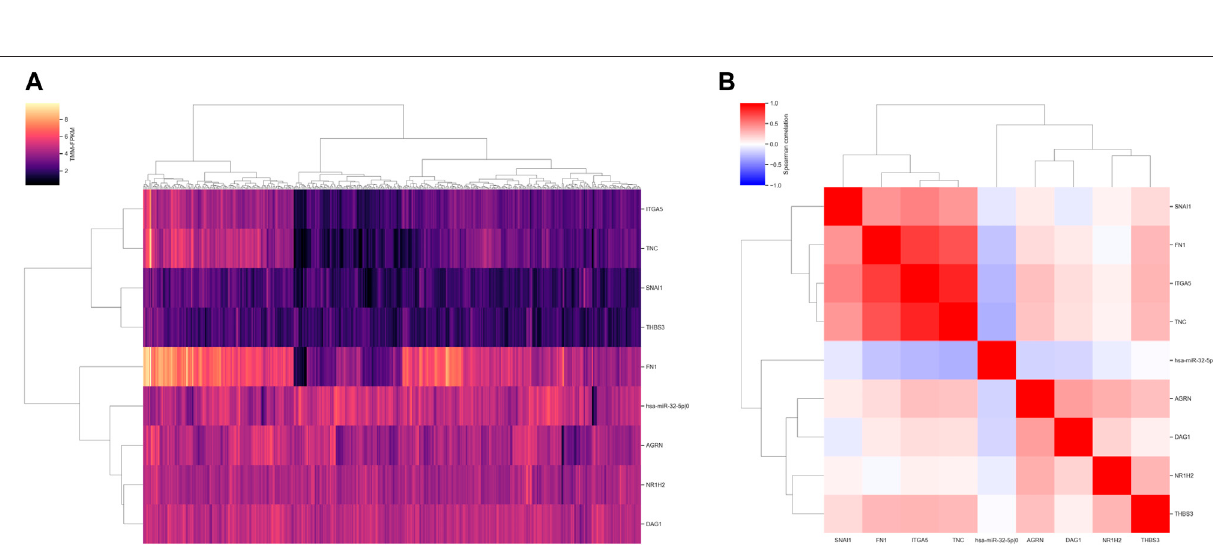
Frontiers in Genetics |